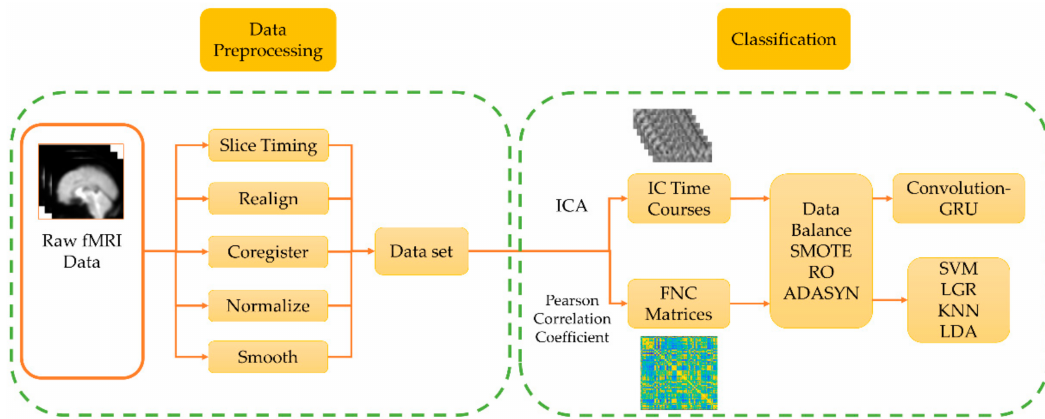
Figure 1. The data processing framework of this study is divided into two parts: data preprocessing and classification. In the data preprocessing, the standard preprocessing process of functional magnetic resonance imaging (fMRI) is used. In data classification, independent component analysis (ICA) and Pearson correlation coe ffi cients are performed on the processed data respectively to obtain independent component (IC) time courses and functional connectivity (FNC) matrix. After data balancing, the convolution-Gated Recurrent Unit (GRU) network and the traditional classifier are used for classification and the performance is